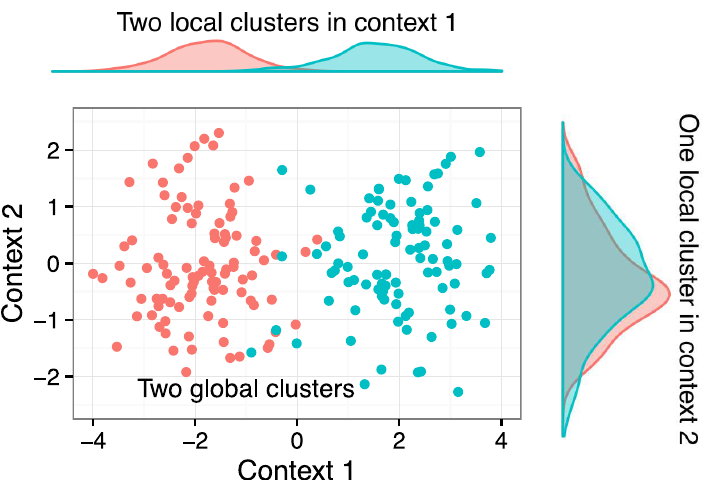
Fig 1. Illustration of heterogeneous cluster structures in two contexts (datasets). Each context corresponds to different data source (gene expression, ribosome profiling,proteomics etc.) describing the same set of biologicalsamples. In the first context, there are two distinct clusters on the local level. In the second context, there is only a single local cluster. From the overall perspective, there are two globalclusters definedby the combinedbehaviour across the two